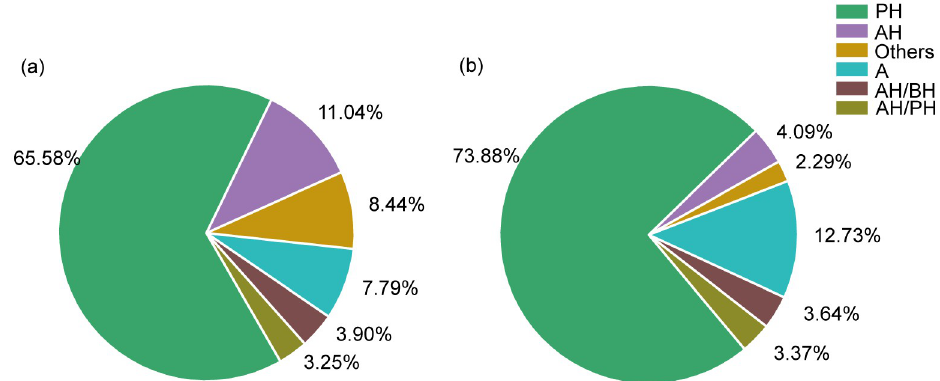
Fig 8. Pie chart of plant feeding parts of the zokors. a and b are the proportion of the number of plant species and the number of ASVs of the feeding type of zokor.